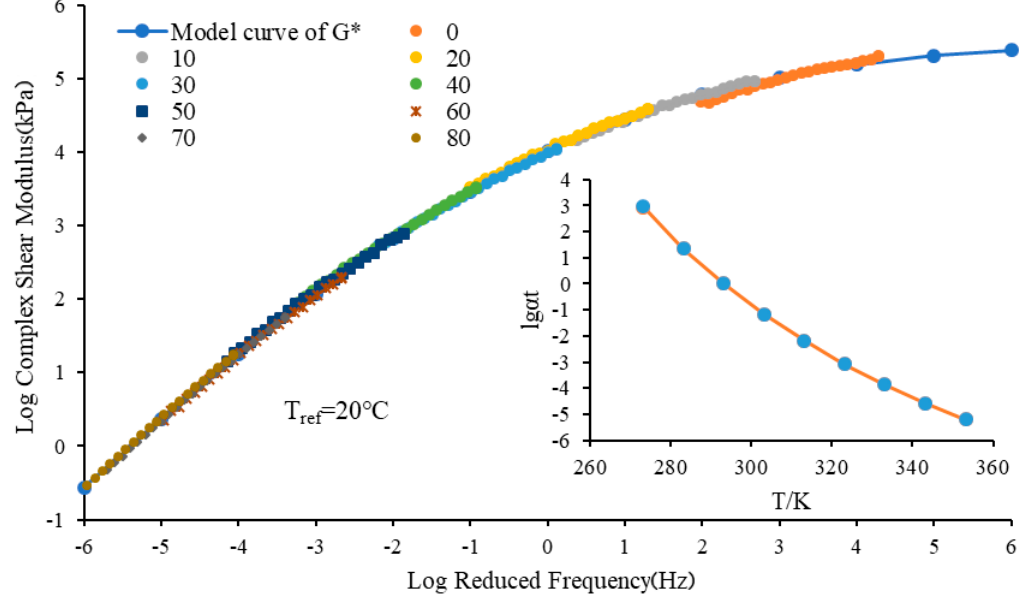
Figure 3. Complex shear modulus master curve and displacement factor of A70 SBS modified asphalt at 293.15 K.